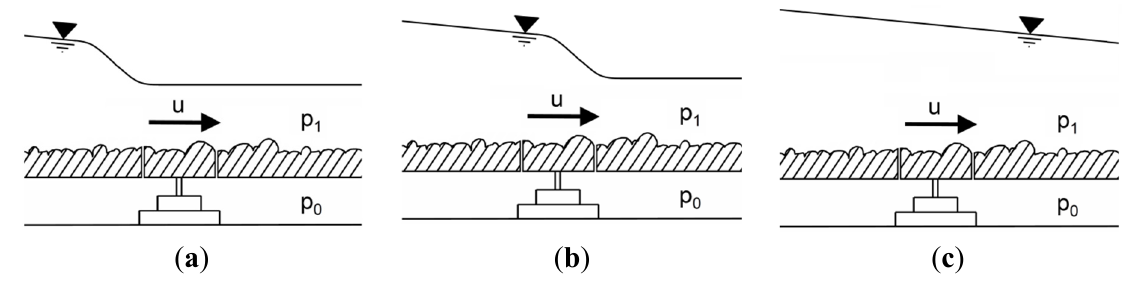
Figure 11. Schematic water level above the test section during the occurrence of the dynamic lift peaks: ( a ) Peak 1; ( b ) Peak 2; and ( c ) Peak